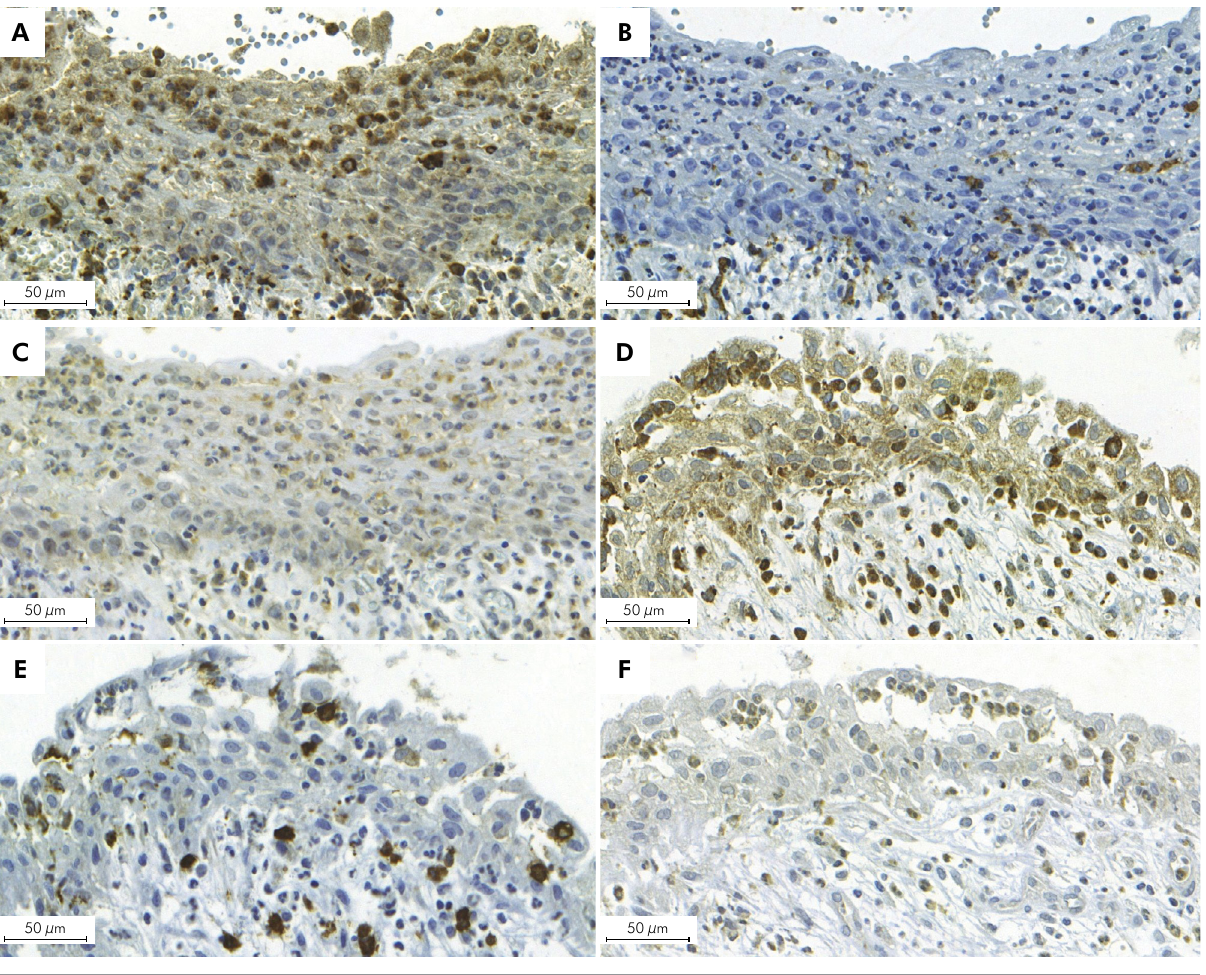
Figure 3. A, B, and C are from the same case. (A) High percentage of CD68 immunostaining in the RC hyperplastic epithelium (Scale bar 50 μ m); (B) Low percentage of CD163 immunostaining in the RC hyperplastic epithelium (Scale bar 50 μ m); (C) Score 4 TNF- α immunostaining in the hyperplastic RC epithelium (Scale bar 50 μ m); D, E and F are from the same case. (D) High percentage of CD68 immunostaining in the RC atrophic epithelium (Scale bar 50 μ m); (E) Low percentage of CD163 immunostaining in the RC atrophic epithelium (Scale bar 50 μ m); (F) Score 3 TNF- α immunostaining in the RC atrophic epithelium (Scale bar 50 μ